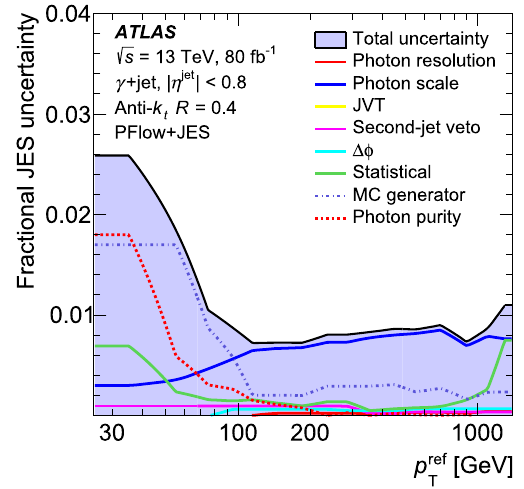
Fig. 14 Systematic uncertainties on PFlow jets as a function of refer- ence p T for γ +jet events calculated using the MPF technique. Uncer- tainties due to the JVT, second-jet veto, and (cid:7)φ cuts derive from the analysis technique. Photon scale and resolution uncertainties are prop- agated through the analysis from the uncertainties associated with the individualobjects.ThestatisticaluncertaintiescomefromtheMCsimu- lation/data ratio while the difference between the Pythia 8 and Sherpa samples defines the MC generator uncertainty. All uncertainties are smoothed to ensure that the visible fluctuations are statistically